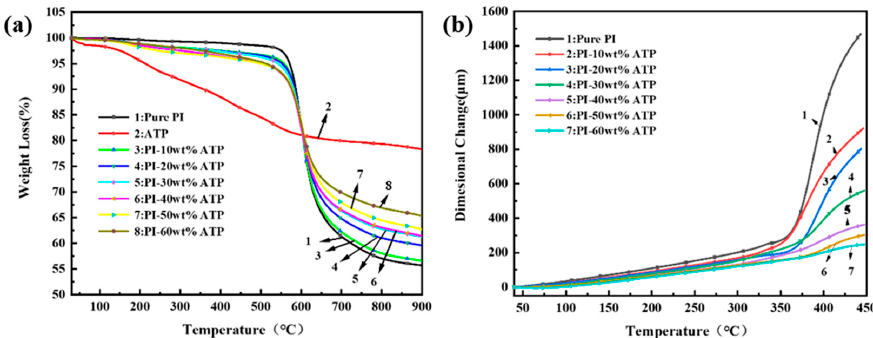
Figure 7. ( a ) TGA curves ( b ) TMA curves of pure PI and ATP/PI composite